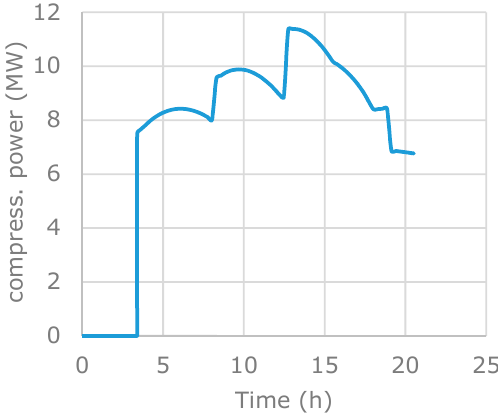
Figure 23. Compressor power (H 2 loading).